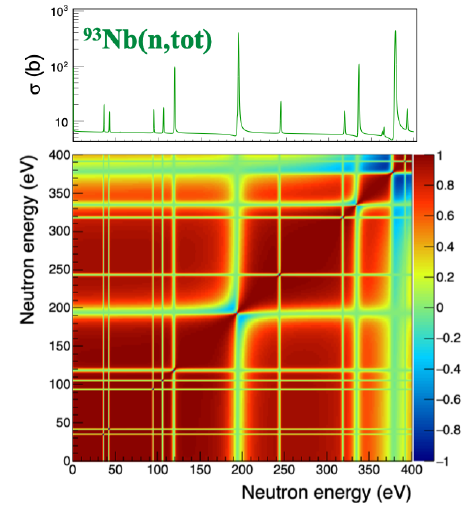
Figure 3. Calculate total cross-section and its correlation matrix on 93 Nb with prior parameters and uncertainties described in the